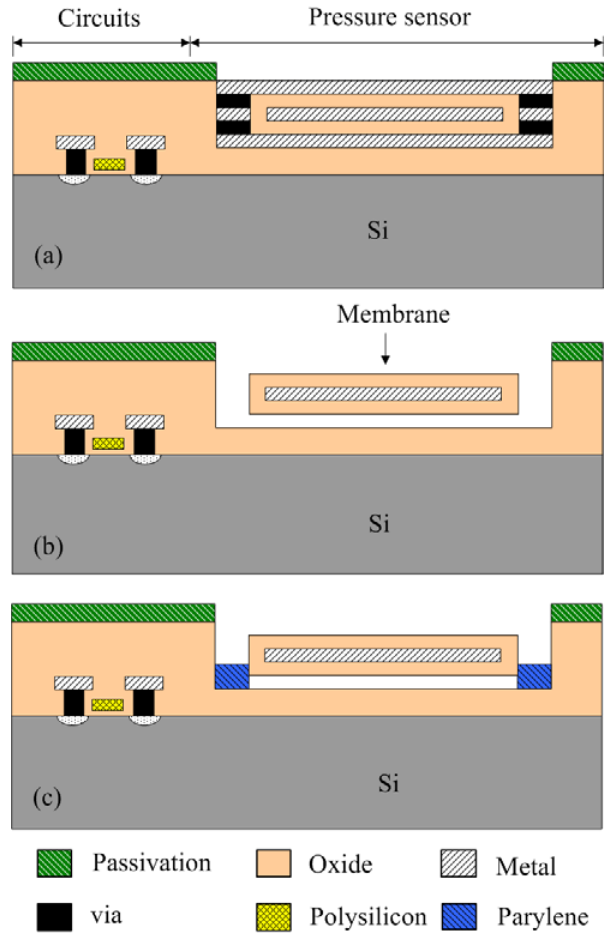
Figure 7. Process flow of the pressure sensor: (a) after completion of CMOS process,